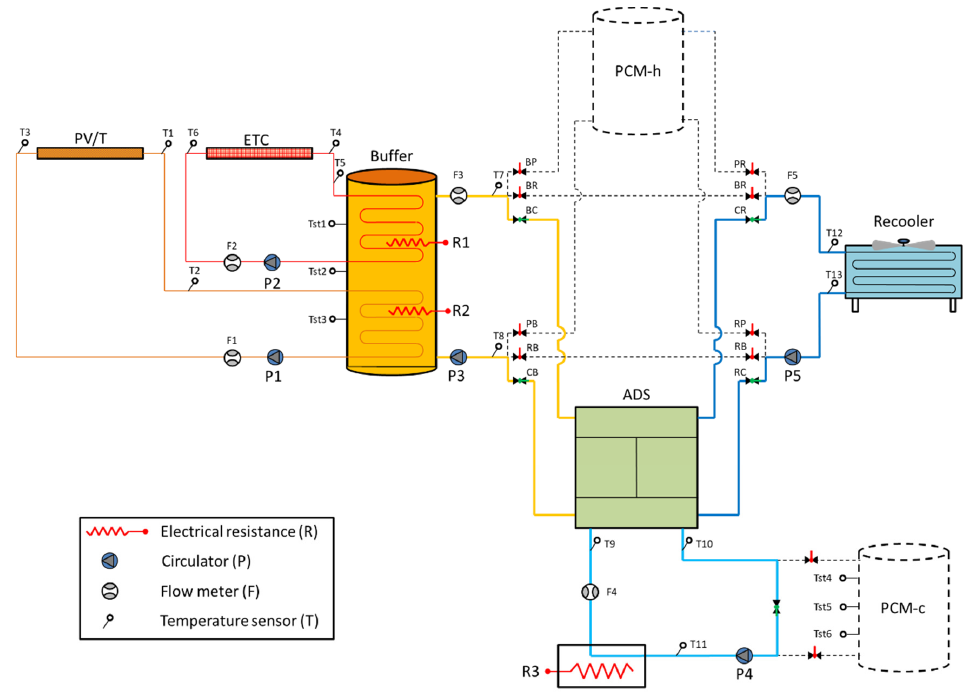
Figure 2. Layout of the experimental solar system.